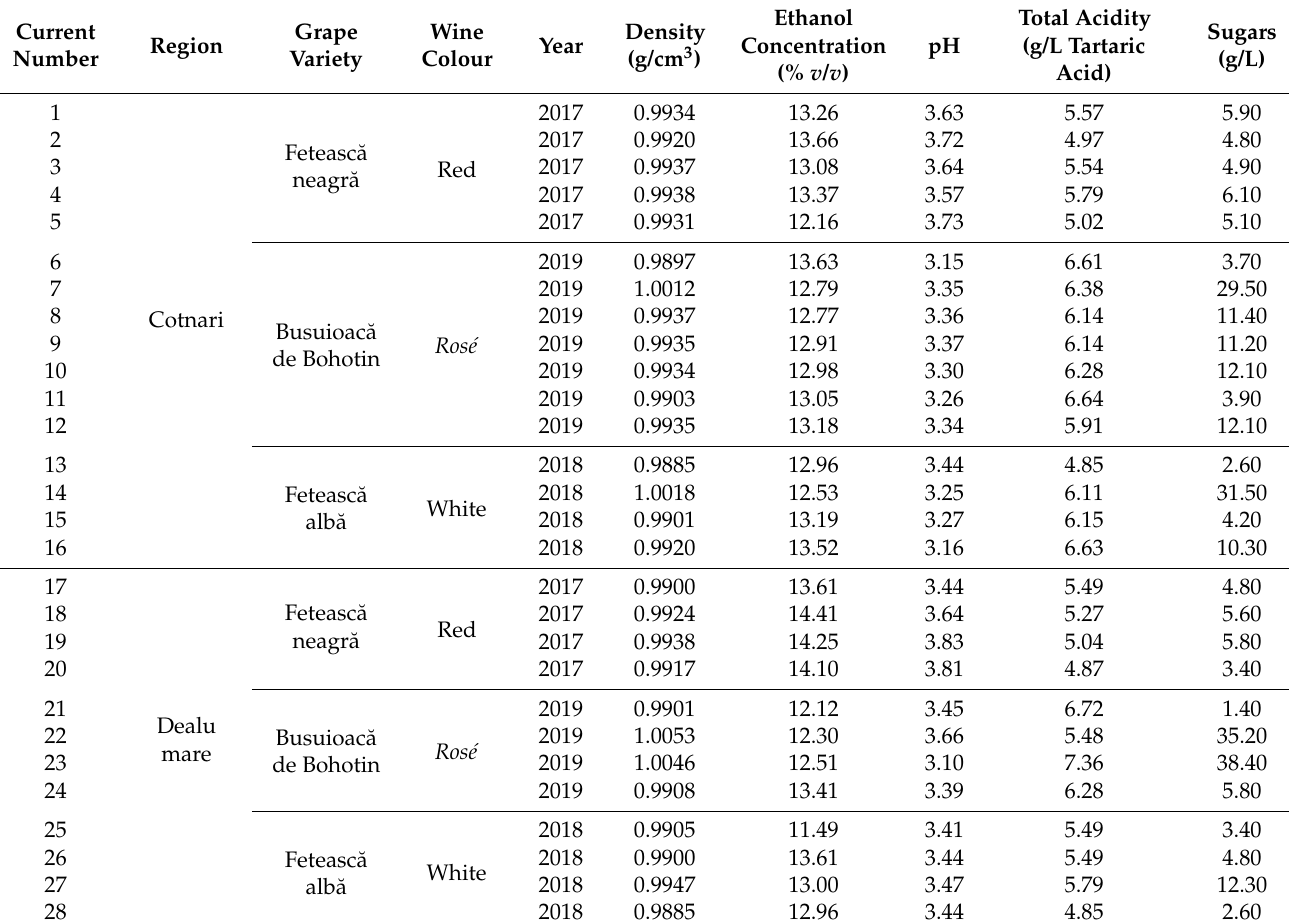
Table 1. Physico-chemical characteristics of the studied